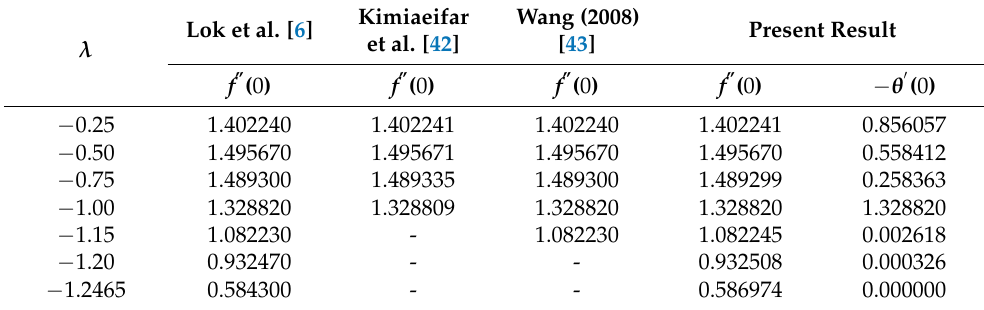
Table 3. Results of f (cid:48)(cid:48) ( 0 ) and − θ (cid:48) ( 0 ) with different λ as φ 1 = φ 2 = K = Rd = 0 and Pr = 6.2.